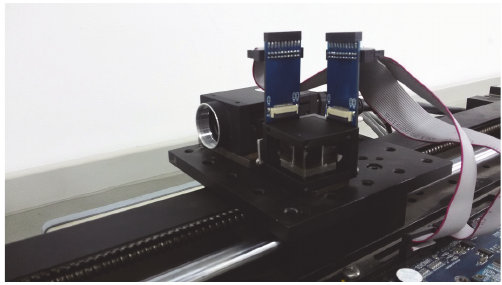
Figure 11: The detectors and transflective